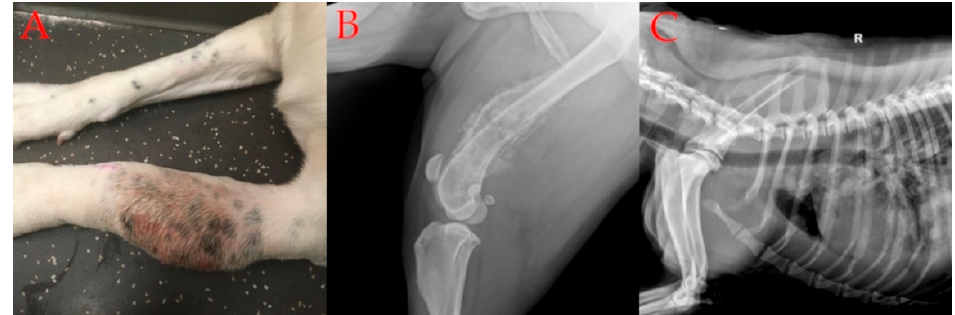
Figure 1. ( A ): Clinical appearance of an 11-month mixed breed dog with osteosarcoma; ( B ): X-ray of the primary canine osteosarcoma localized in the distal femur; ( C ): X-ray of lung metastases in canine osteosarcoma.